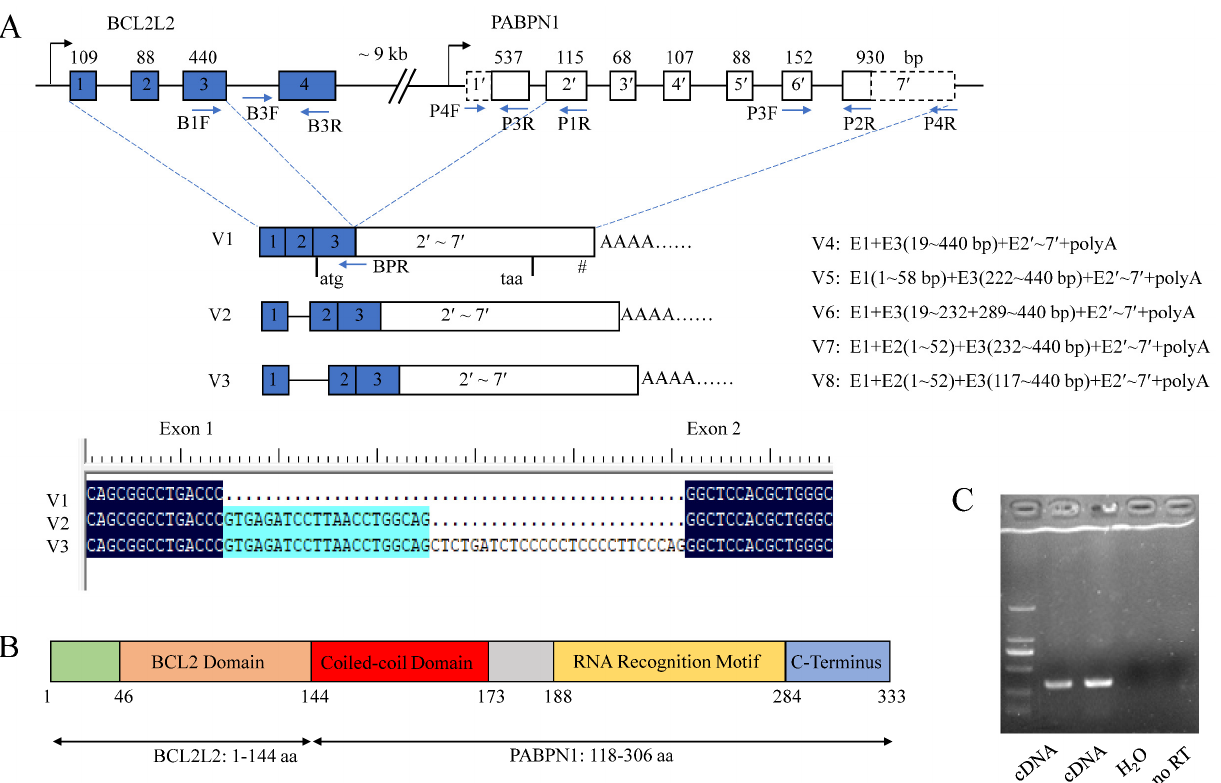
Figure 3. Characterization of porcine BCL2L2-PABPN1 (BP). ( A ) Genomic and mRNA structure of porcine BP. Boxes and lines indicate exons and introns, respectively. Dotted boxes in PABPN1 indicate that the sequences are first obtained here. Figures over the boxes indicate the length of the corresponding exons, while those in the boxes indicate exon No. Primer locations are shown with arrows. E, exon. I, intron. # indicates the position of poly(A) signal. Start and stop codons are shown under the boxes. ( B ) Motifs in the polypeptide of BP. ( C ) Identification of mechanisms underlying BP formation with RT-PCR. Templates were showed below. No RT, no reverse transcriptase control.